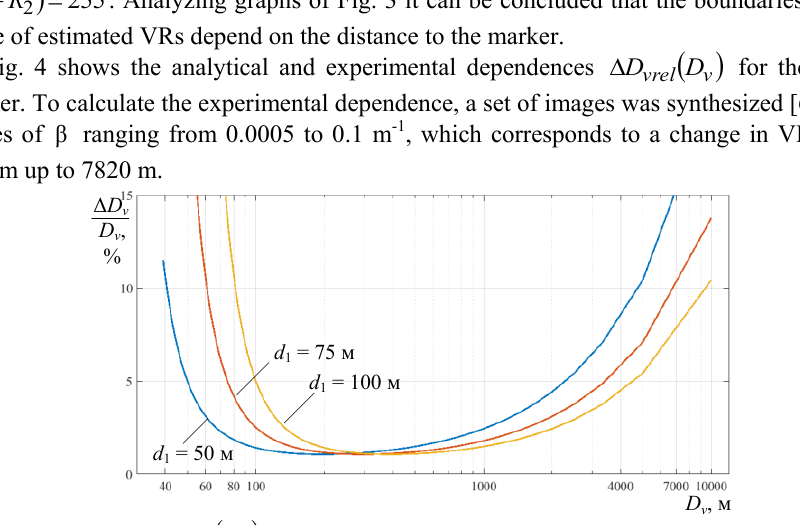
Fig. 3. Dependencies   vvrel DD  with distance 1 d used as a parameter.